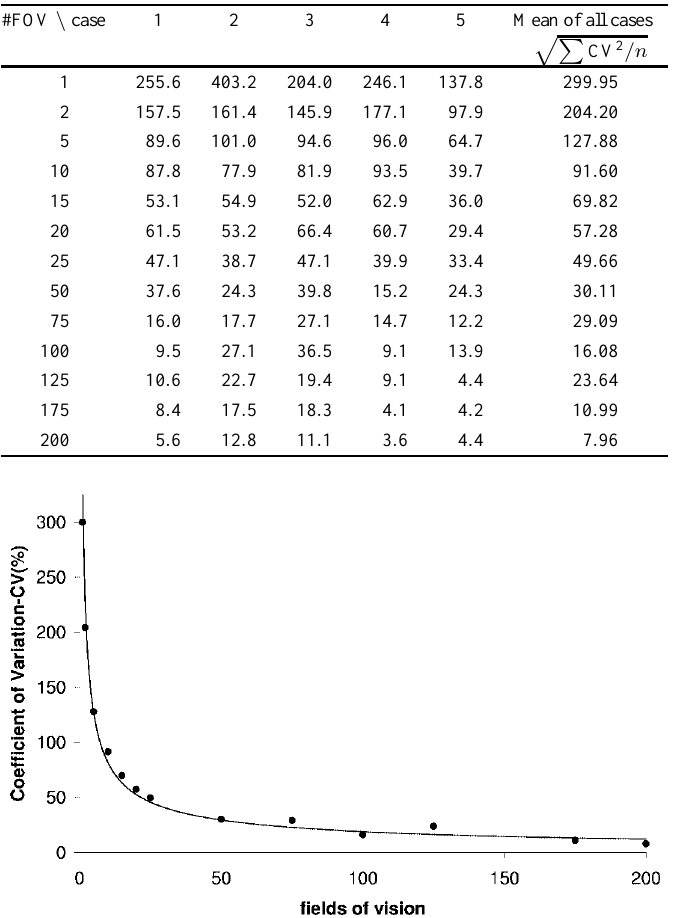
Fig. 3. Mean CV for the 20 specimens as a function of the number of fields of vision (FOV) used to assess the fractional volume of S100 positive cells in a specimen. Note that the CV gradually drops with increasing sample size. and no selection within the nodes has taken place.